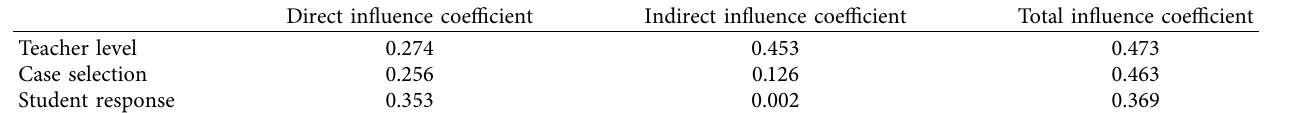
Figure 7: Specific verification results of research hypotheses. Table 5: The influence of each latent variable on teaching effect.